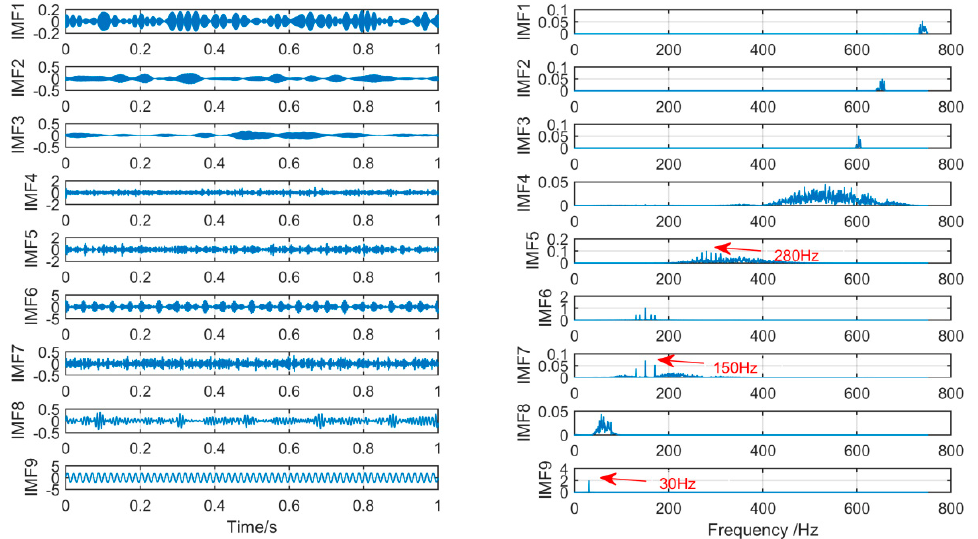
Figure 10. The spectrum of IMFs after SSD and its corresponding spectrum after an increase in the noise amplitude.